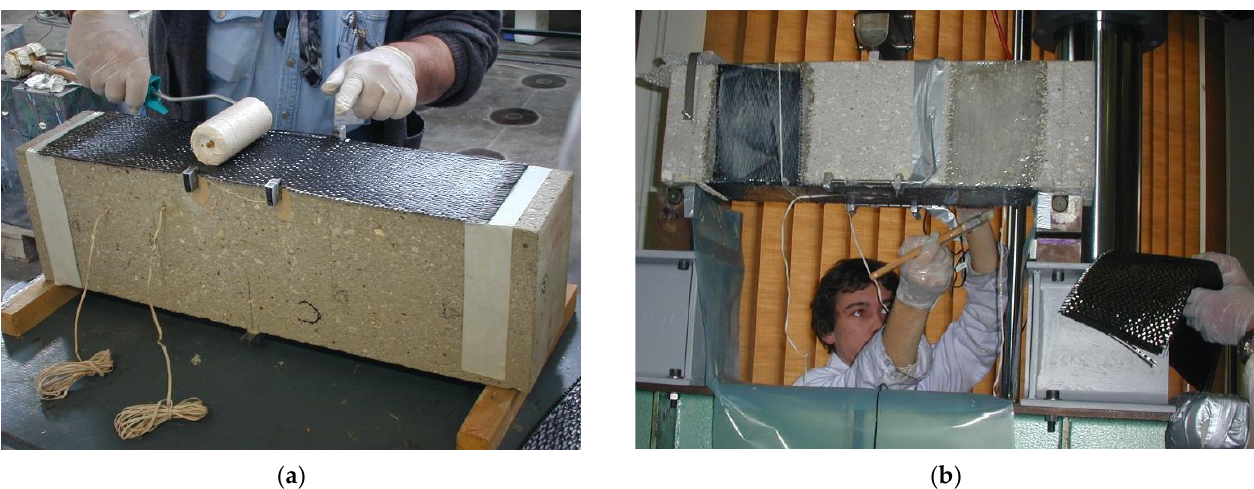
Figure 6. Strengthening of specimens: ( a ) beam ES1 positioned upside down; ( b ) CFRP strips bonded as in the field (technicians working under the beam ES2).